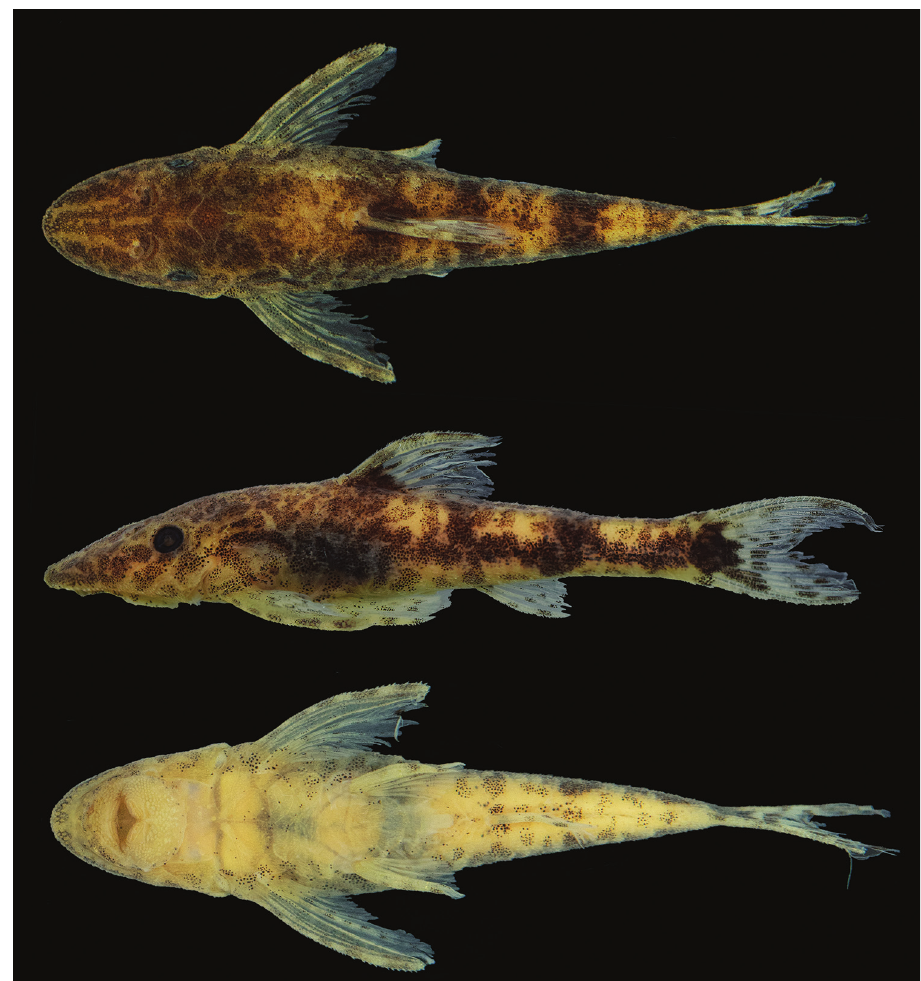
Figure 1. Parotocinclus dani , MZUSP 120737, 27.3 mm SL, holotype from small tributary of rio Peixoto de Azevedo, rio Tapajós basin, municipality of Peixoto de Azevedo, Mato Grosso State, Brazil.